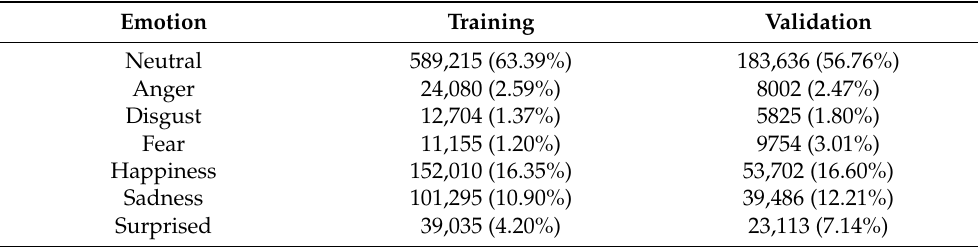
Table 1. The class distribution of the AffWild2 dataset.